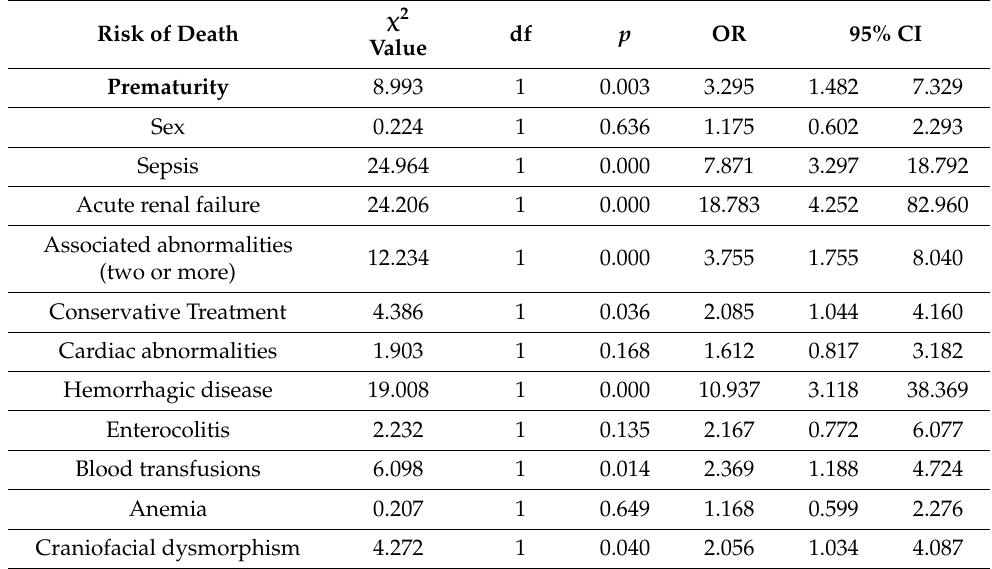
Table 2. Chi-square tests for statistical variables considered individually and the risk of